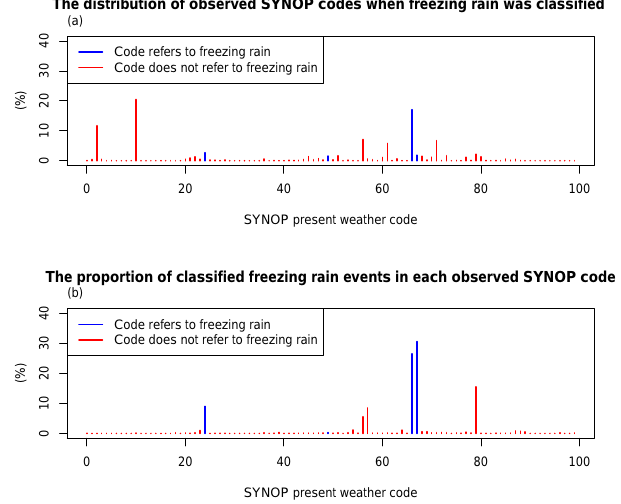
Figure 6. (a) The distribution of observed SYNOP present weather codes when an event was classified as FZRA by the FMI CLIM al- gorithm. The distribution sums up to 100%. (b) The proportion of cases classified as FZRA in each observed SYNOP present weather code. Each code can have a proportion from 0 to 100%.